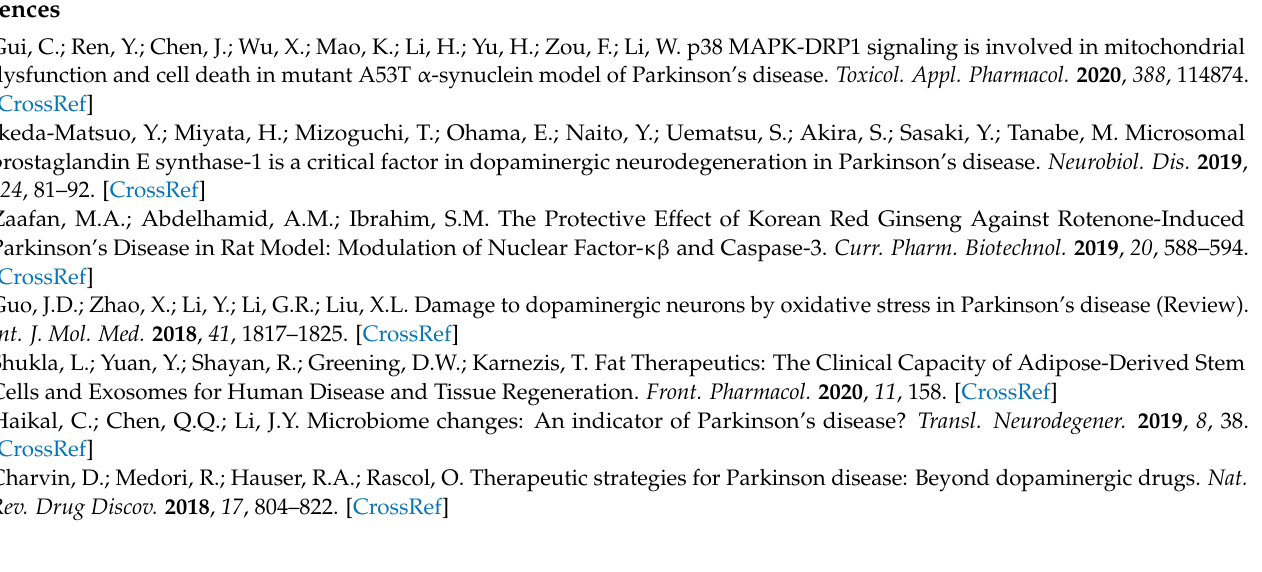
and edges reflect protein–protein associations. The texts inside the elliptic nodes represent genes names. Figure S4: PPI networks construction and module analysis of GSE22491 blood DEGs. The nodes represent proteins and edges reflect protein–protein associations. The texts inside the elliptic nodes represent genes names. Figure S5: Timeline of the in vivo study. Representative figure shows experimental design. Mice were injected intraperitoneally with saline or MPTP (30 mg/kg) once daily for 5 successive days. mRNA measurement was performed on day 6. Behavioral tests were carried out on day 10. Mice were sacrificed after behavioral tests and tissues were collected for protein expression assay. Figure S6: Time course experiment. Mice were administered with saline or MPTP and the rotarod test was applied at 1, 2, 3, 4 and 5 days after the last MPTP intraperitoneal injection. Data are expressed as mean ± S.E.M. Two groups were analyzed by Student’s t -test. *** p < 0.001. Table S1: DEGs in GSE 8397 and GSE 22491. Table S2: GO enrichment analysis of GSE 8397 and GSE